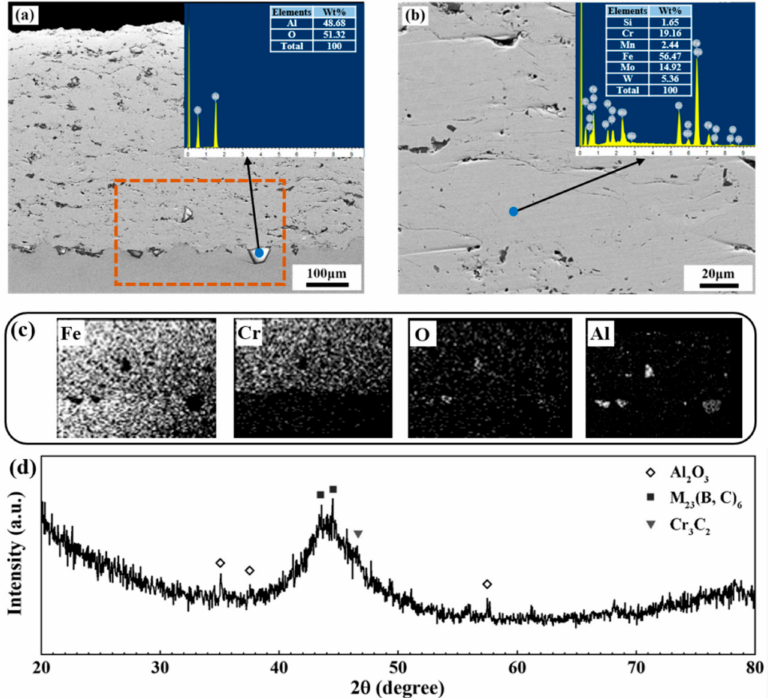
Figure 1. The morphology of the cross-section and the XRD plot of the Fe-based amorphous coatings (AMCs). ( a ) low magnification image (SEM); ( b ) local enlarged image; ( c ) elements mapping; ( d ) XRD